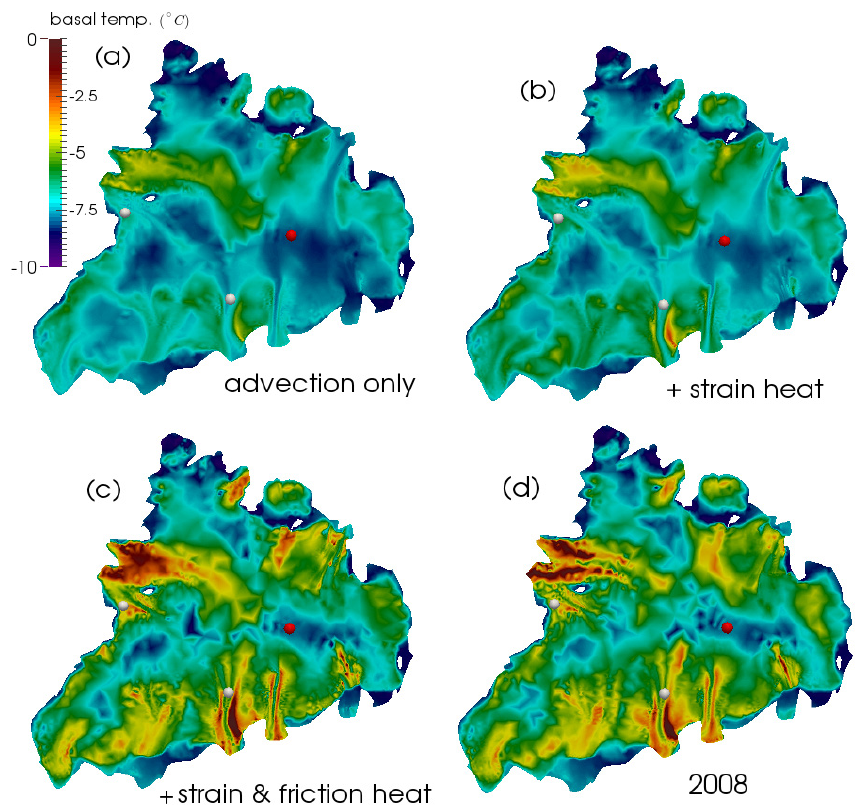
Figure 6. Basal temperature field ( ◦ C, relative to pressure melting): (a) advection only ( 1995ssA ), (b) adding of strain heating ( 1995ssSH ), (c) adding of friction heating for 1995 ( 1995ss ), (d) advection, strain and friction heating for 2008 ( 2008ss ). The position of the ice core is indicated in red, the position of the two locations used in Fig. 7 in white.